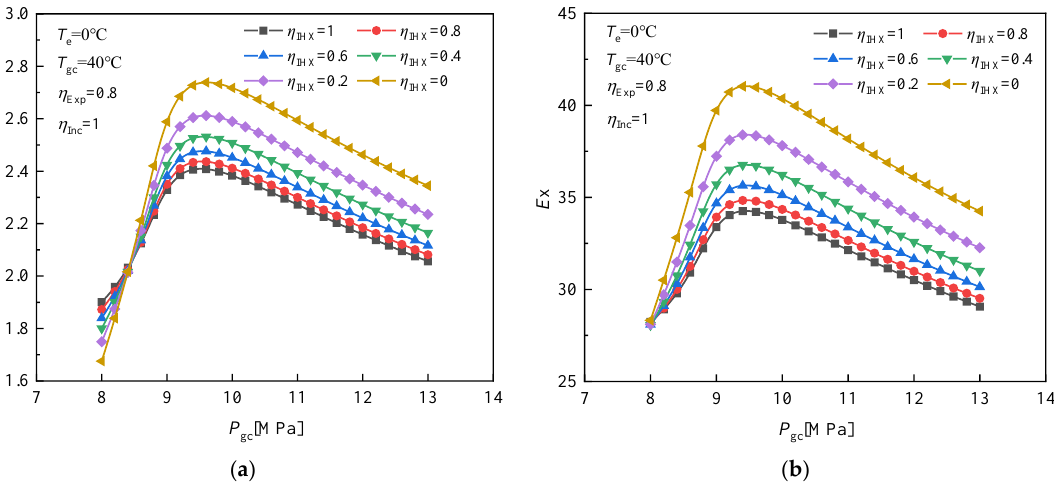
Figure 4. Effect of η IHX on the performance of trans-critical single-stage refrigeration system: ( a ) Variation of COP with P gc ; ( b ) Variation of exergy efficiency with P gc .